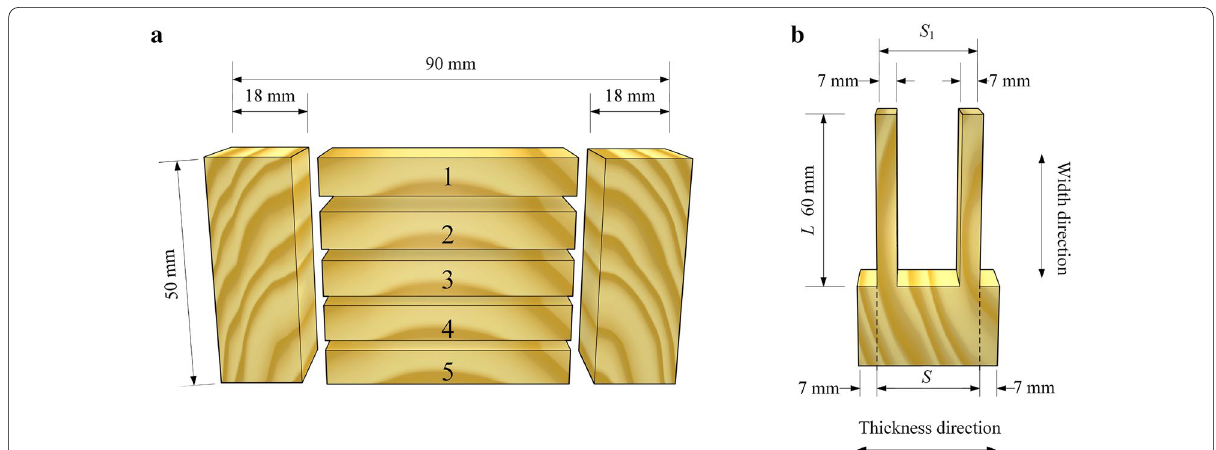
Fig. 3 a Schematic of layered MC test specimen. b Schematic of stress test